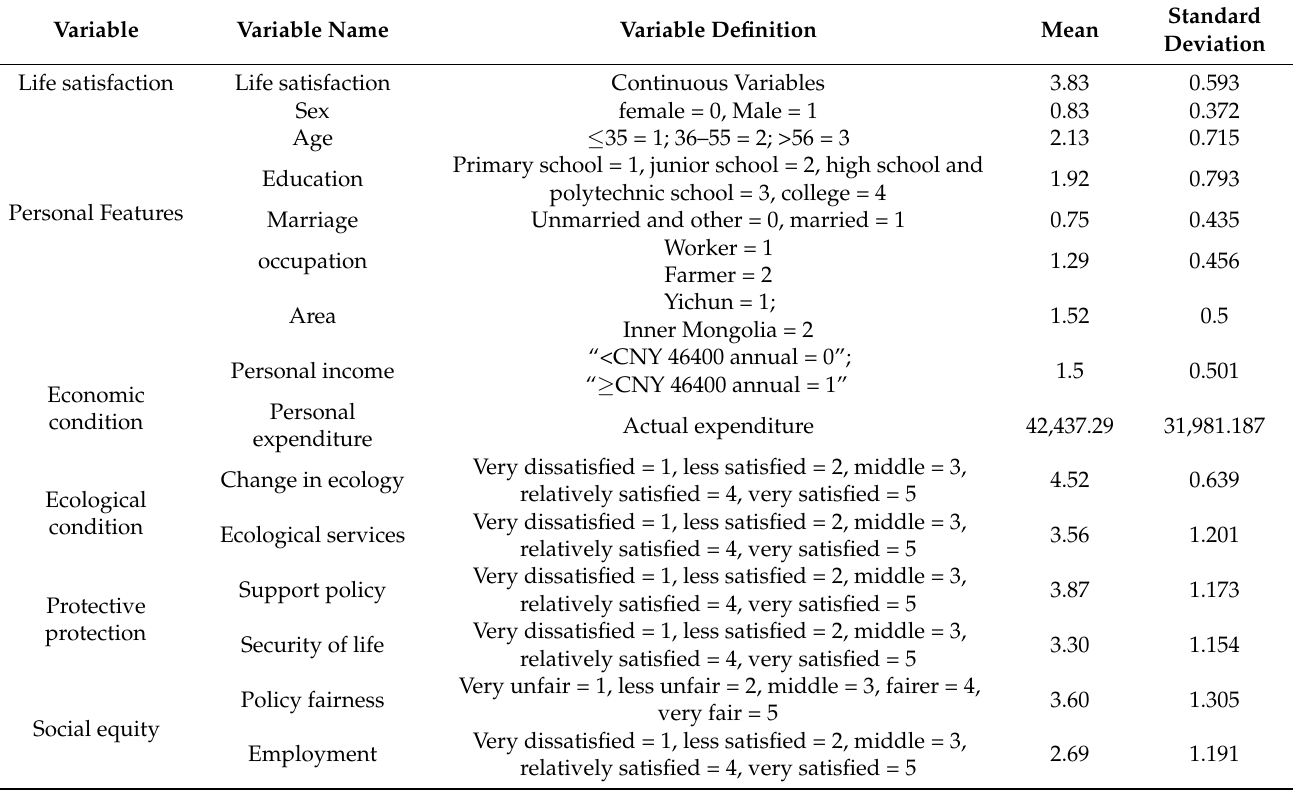
Table 2. Variable definitions and descriptive